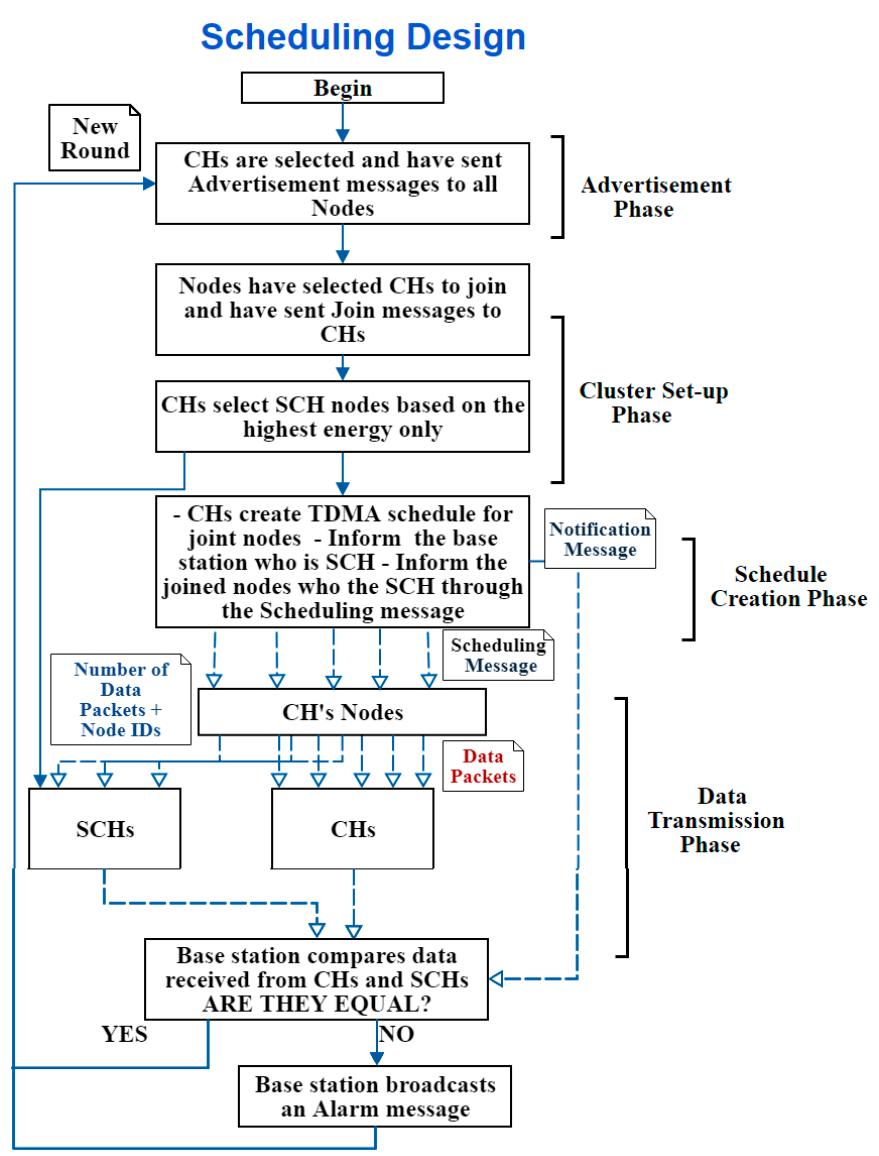
Figure 6. Scheduling design process.